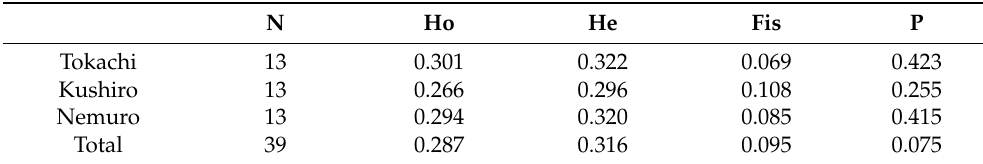
Table 3. Some parameters of population genetics in Tokachi, Kushiro and Nemuro in eastern Hokkaido using InDel markers.